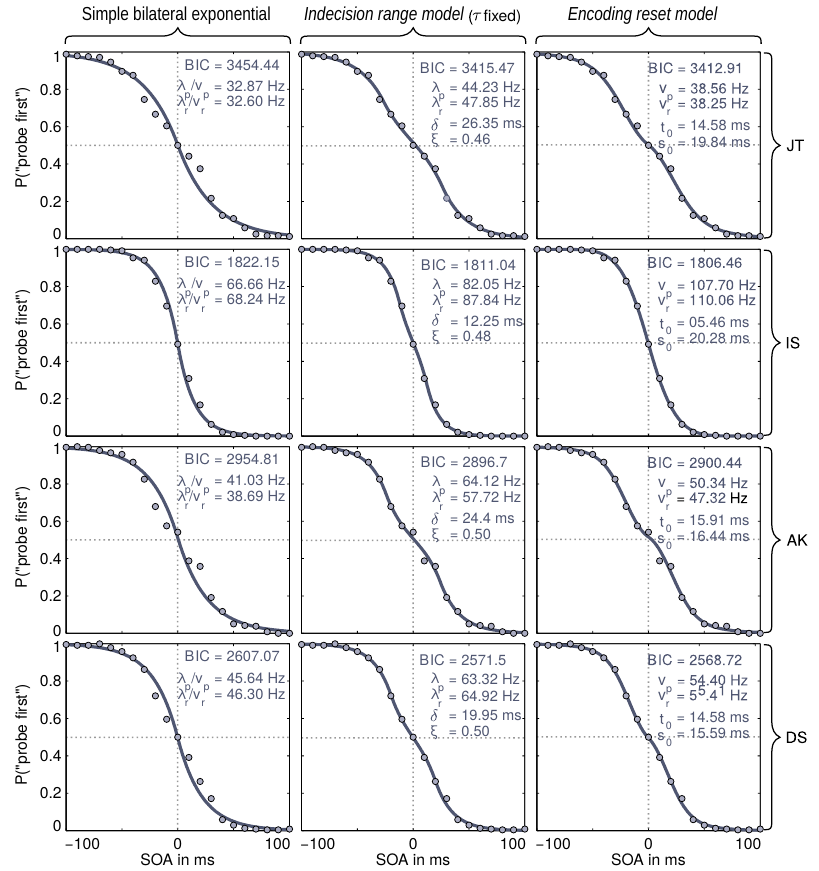
Figure 3. Data, fits, and parameters in Experiment 1. The rows show the different participants, labeled with initials. The columns are the different models, identified in the heading at the top. Data points are the frequencies of the judgment “probe first” for the 21 stimulus onset asynchronies (SOAs) studied. In each panel, the respective Bayesian information criterion (BIC) score and all used parameters are given: parameters λ and v are the speed parameters for probe and reference (identified by the subscripts p and r ). The δ parameter is the size of the range of indecision and bias ξ its location on the y -axis. Threshold t 0 is the minimal effective exposure duration and s 0 its standard deviation. For detailed definitions of the parameters, please refer to Section